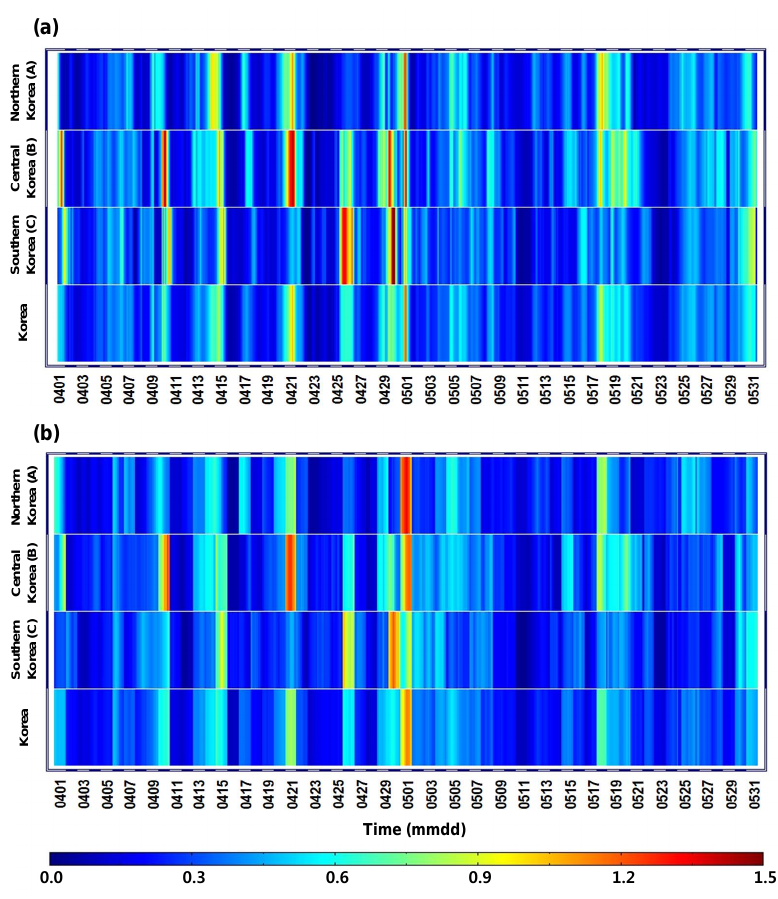
Fig. 9. Time series plots of daily and regionally averaged AODs, based on AOD products calculated via Chin et al.’s (2002) algorithm ( a ) and Figure 9. Time-series plots of daily- and regionally-averaged AODs, based on AOD products calculated via Chin et al. (2002)’s algorithm (panel (a)) and Park et al. (2011)’s algorithm (panel (b)) Park et al.’s (2011) algorithm ( b ) over northern Korea (A), central Korea (B), southern Korea (C), and the entire Korean peninsula, shown in over Northern Korea (A), Central Korea (B), Southern Korea (C), and the entire Korean peninsula, Fig. 1, for the modeling period of 1 April to 31 May shown in Fig. 1, for the modeling period of 1April to 31 May, 2011.